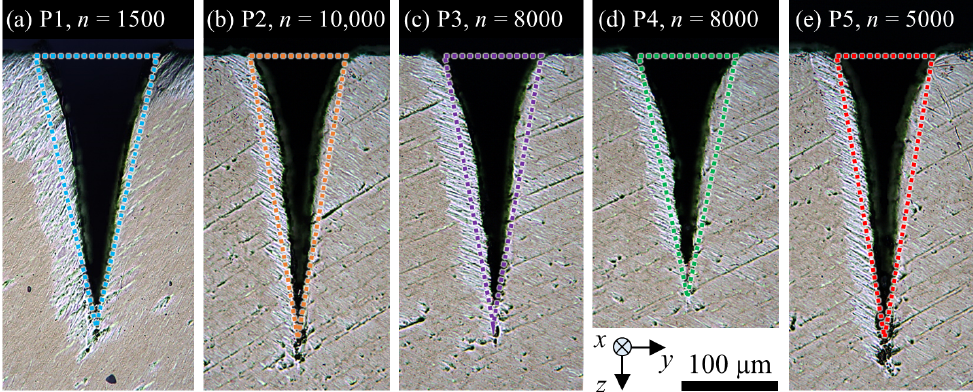
Figure 5. Cross sections of grooves micromachined in Ti6Al4V with ( a ) P1, n = 1500, ( b ) P2, n = 10,000, ( c ) P3, n = 8000, ( d ) P4, n = 8000, and ( e ) P5, n = 5000. An isosceles triangle with the dimensions of the calculated depth and width of the corresponding groove using the model presented in Section 2 is inserted for each parameter set in the respective colour.